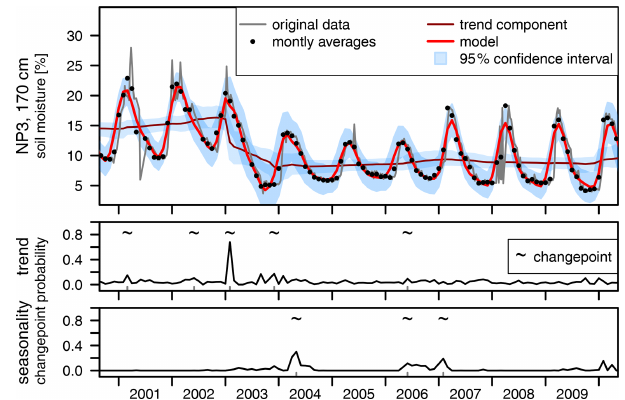
Figure 11. Results of time-series decomposition for NP3 at a depth of 170cm. Change points and their respective probability distribu- tions are shown